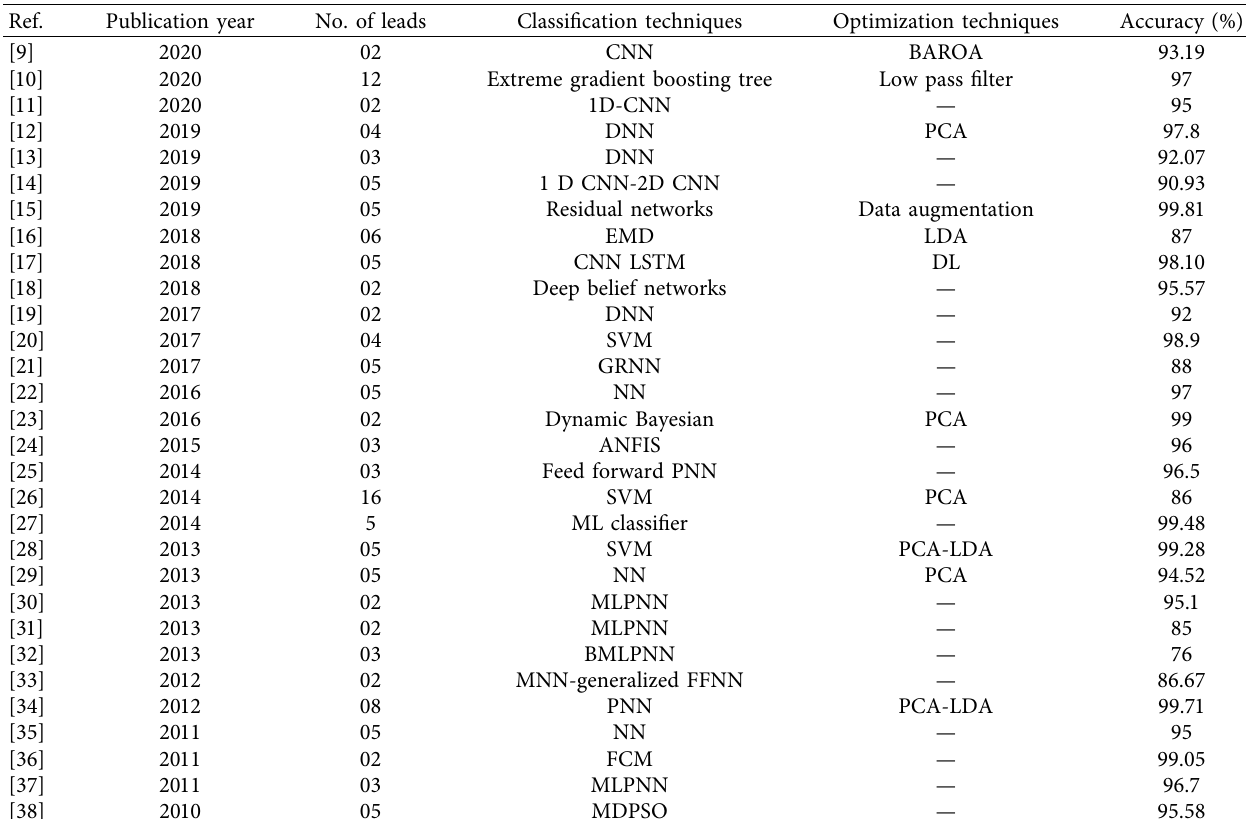
Table 2: Arrhythmia classification techniques from 2010 to 2020. Ref.